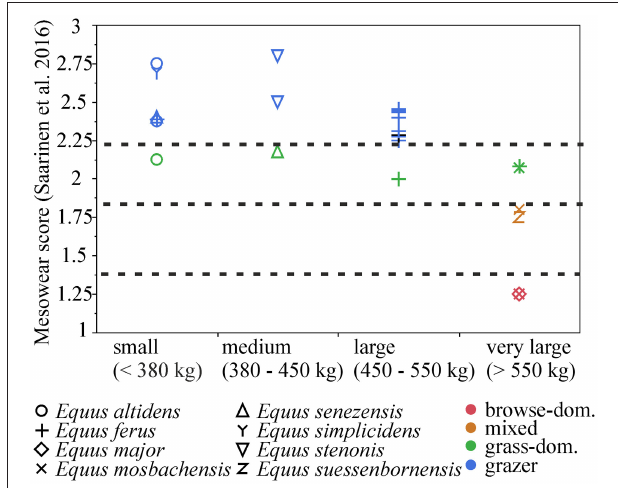
FIGURE 8 | Third metacarpal (A) and third metatarsal (B) Log10 Ratio diagrams of selected measurements in Equus simplicidens, E. grevyi, and E. quagga . The Late Miocene Hippotherium primigenium form Höwenegg (Germany) is used as standard.